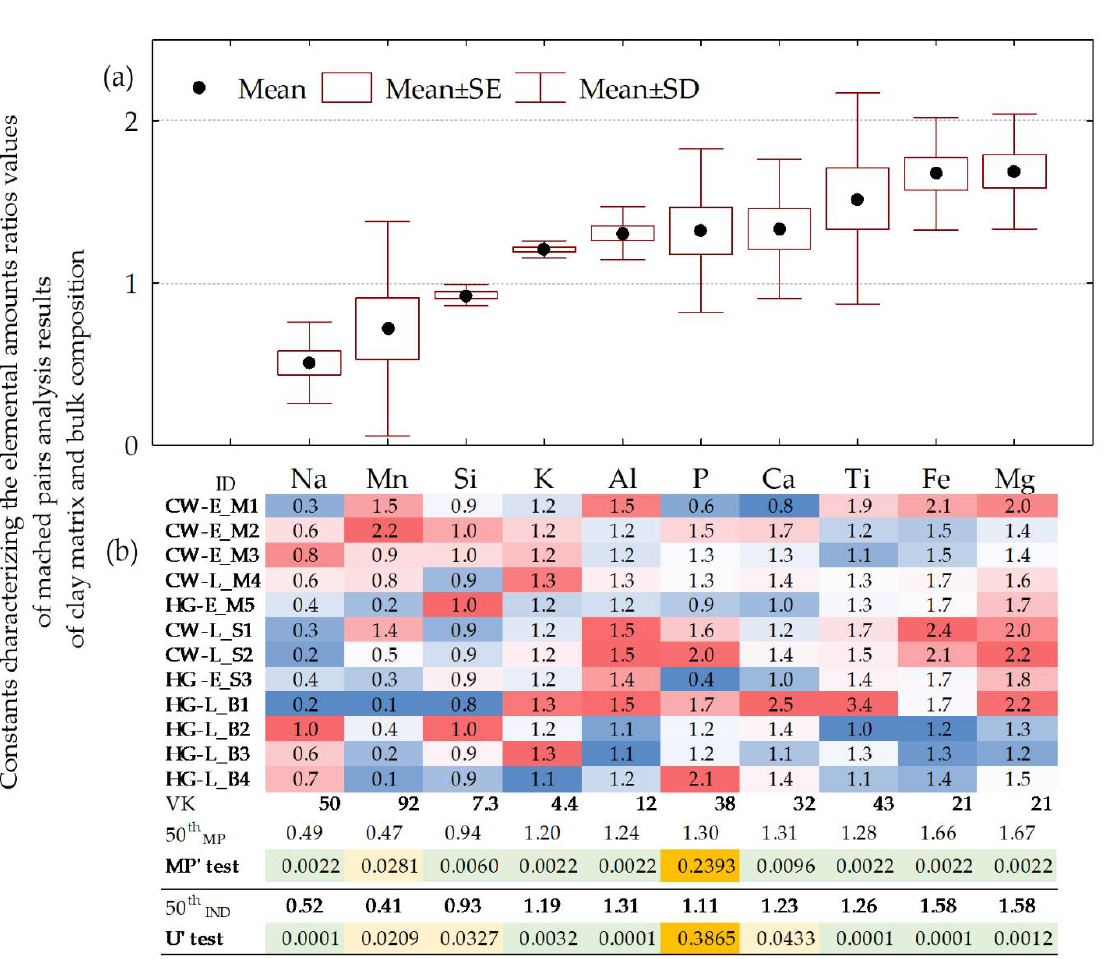
Figure 5. Elemental ratios of matched pairs of SEM-EDS and XRF analysis results for clay matrix and bulk compositions of twelve pottery samples. ( a ) Box and whisker plot. For calculation of ratios, the content in the clay matrix was in the numerator, whereas in bulk compositions, it was in the denominator. ( b ) Elemental ratios of individual matched pairs are conditionally formatted in color scales. 50th MP —median values of ratios for twelve matched pairs. MP’ test— p -values of Wilcoxon Matched Pairs test. 50th IND —ratio of median values of twelve samples (Table S1). U’ test— p -values of Mann–Whitney U test for independent sets. Analytes are given in ascending sequence of mean elemental ratios values.